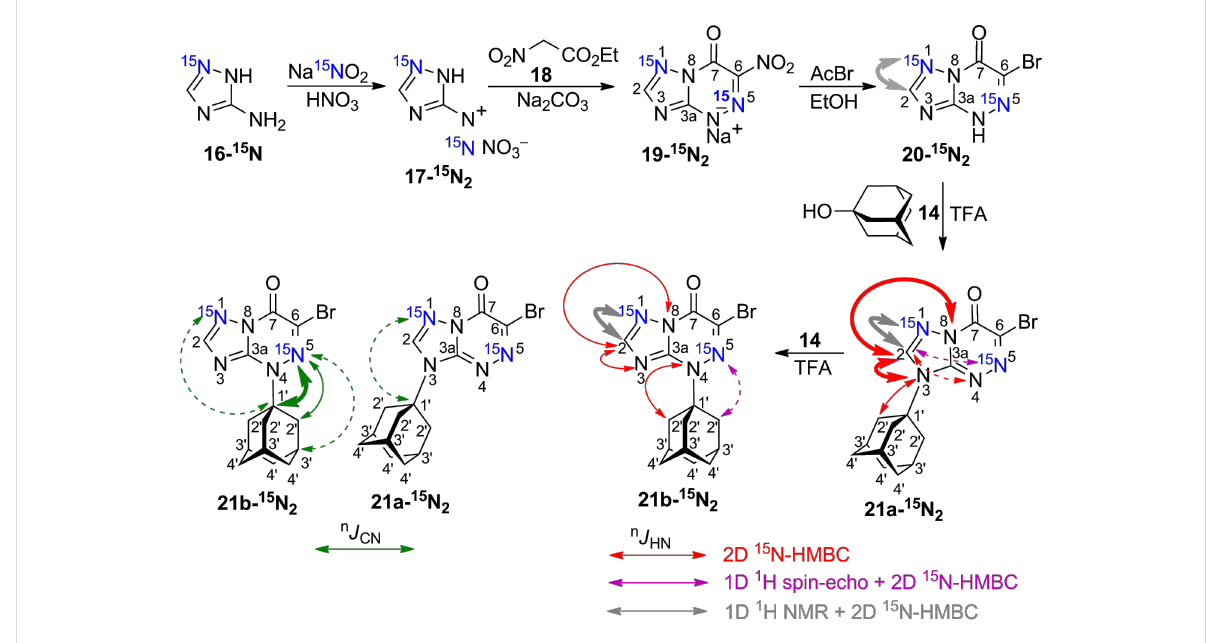
Scheme 2: Synthesis and adamantylation of 15 N-labelled 20- 15 N 2 and J HN and J CN data confirming the structures of adamantylated derivatives 21a,b- 15 N 2 .The J HN couplings measured either in the 1D 1 H spectra or by amplitude-modulated 1D 1 H spin-echo experiments and detected in the 2D 15 N-HMBC spectra are shown by grey, magenta, and red arrows (see the legend in the figure). The measured J HN values (gray and magenta) with magnitudes J ≥ 14 Hz and J < 0.1 Hz are indicated by the bold solid and dashed arrows, respectively. The 1 H- 15 N cross-peaks observed in the 2D HMBC spectrum for the unlabelled nitrogen atoms are classified into three categories: strong, medium and weak (bold solid, thin solid, and dashed red arrows, respectively). The J CN couplings with adamantane carbons measured in the 1D 13 С spectra are classified into three categories: J ≥ 2 Hz, 2 > J ≥ 1 Hz, and J < 1 Hz (bold solid, thin solid, and dashed green arrows, respectively).